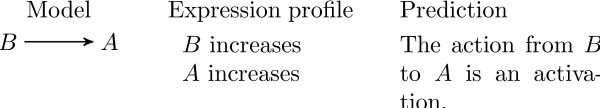
Illustration of the simple inference rule.